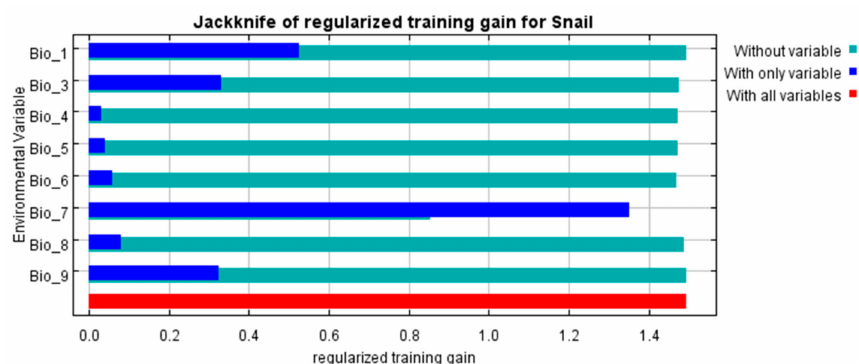
Figure 7. Results of jackknife testing of each variables’ contribution to modeling the O. hupensis habitat suitability distribution. Note: Bio_1, the annual average temperature; Bio_3, humidity of the climate;